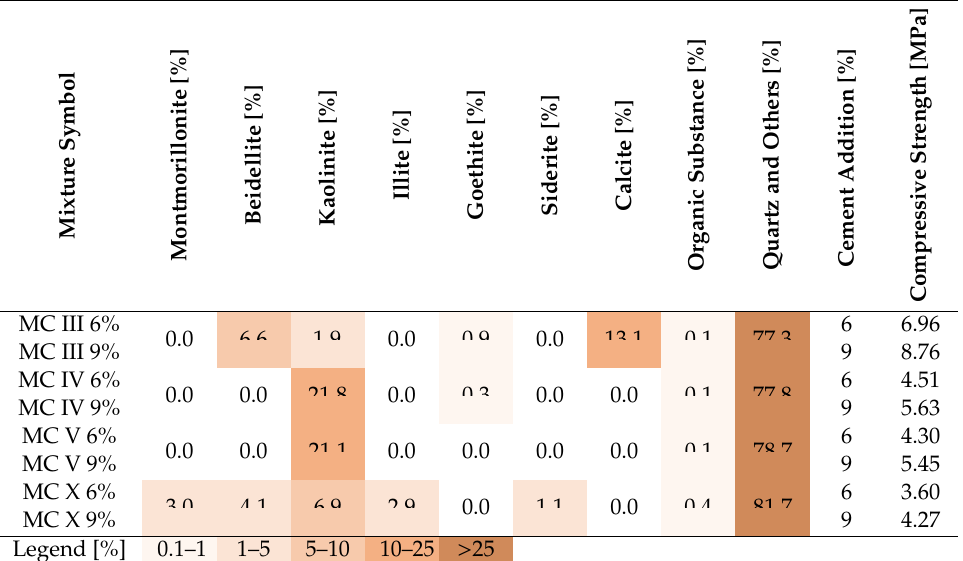
Table 8. Mineral compositions of soil mixtures given in percentages. The table also gives the percentage of water and CEM I 42.5 R cement additions and the average obtained compressive strength of CSRE samples in each series.